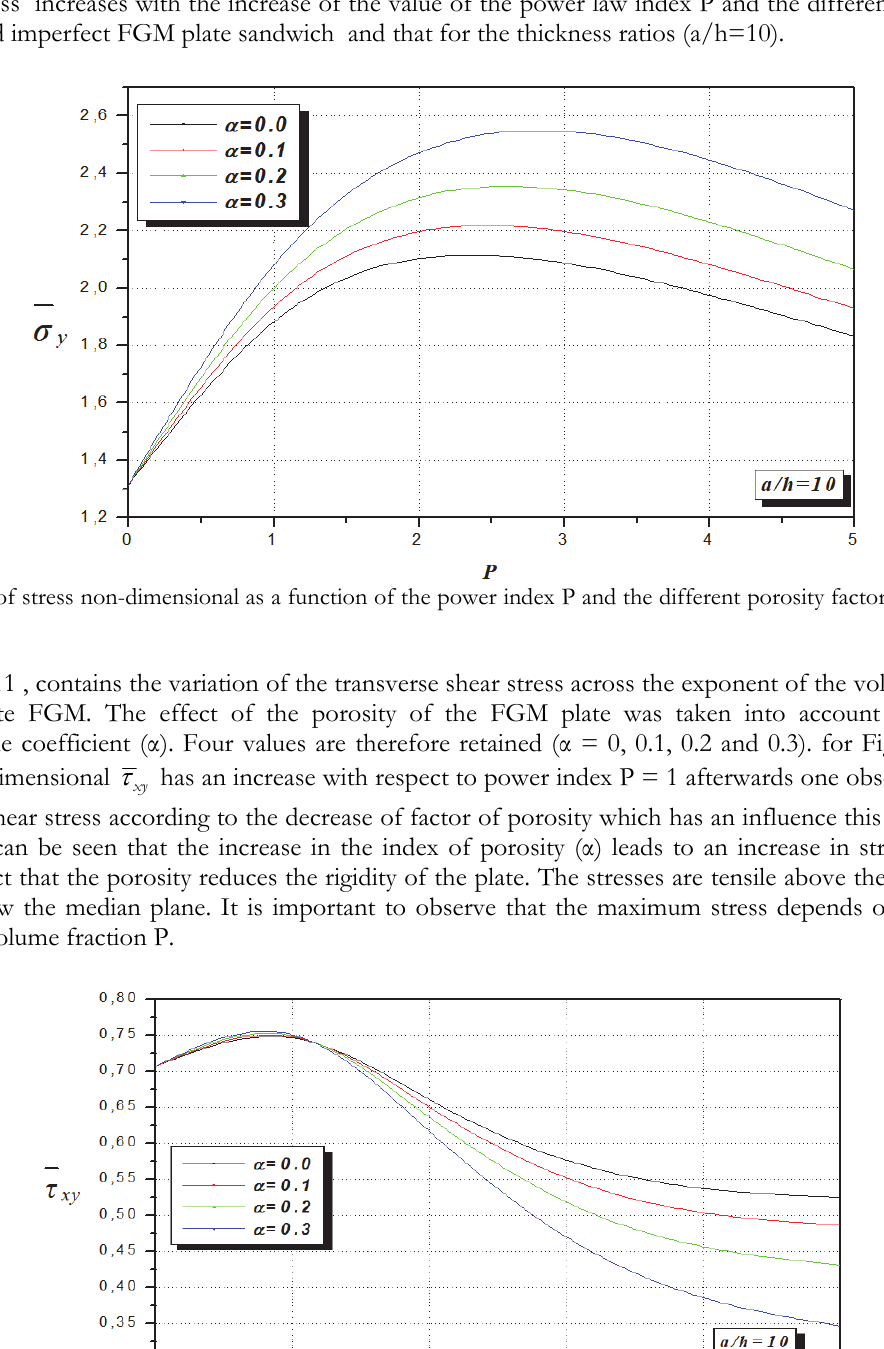
Figure 9: Variation of tangential stress non-dimensional sandwich plate